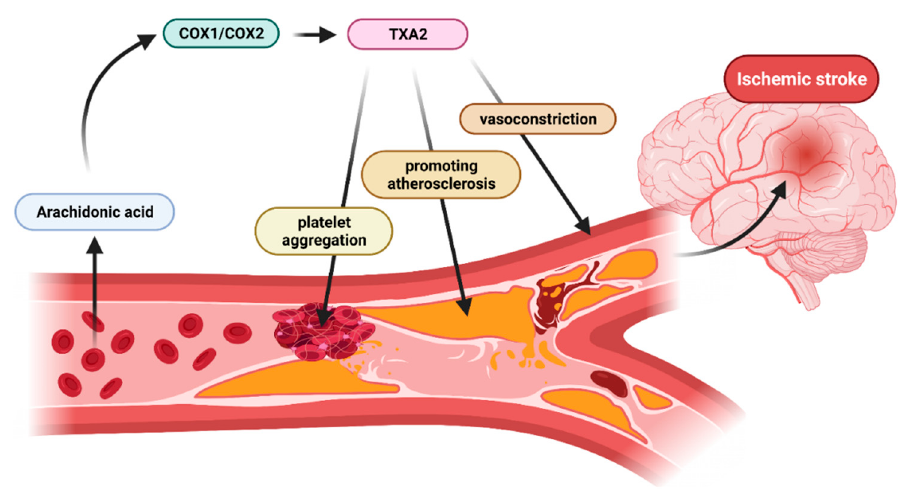
Figure 1. Schematic representation of the mechanism of action of thromboxane in patients with atherosclerosis. Thromboxane induces platelet aggregation leading to clot formation, constriction of blood vessels and plaque deposition (created with BioRender.com https://app.biorender.com/, accessed on 23 October 2021).